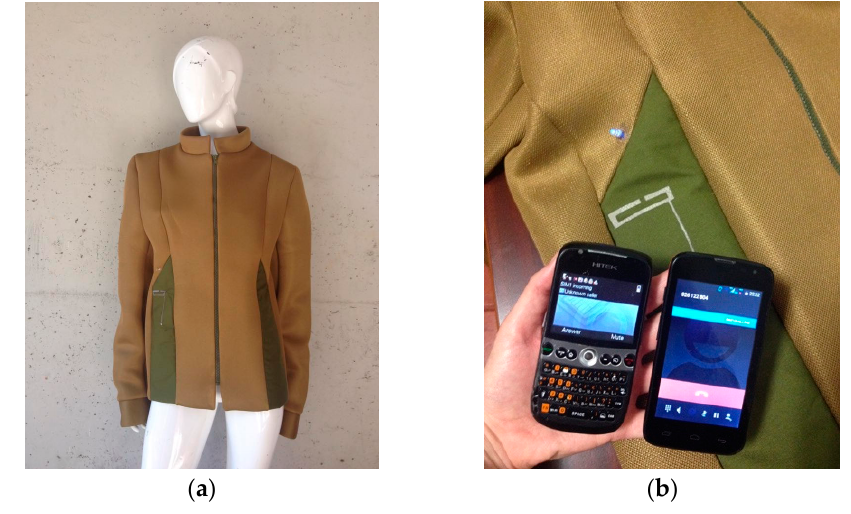
Figure 8. E-Caption: Smart and Sustainable Coat . ( a ) Design of the coat and ( b ) integrated antenna, in detail.